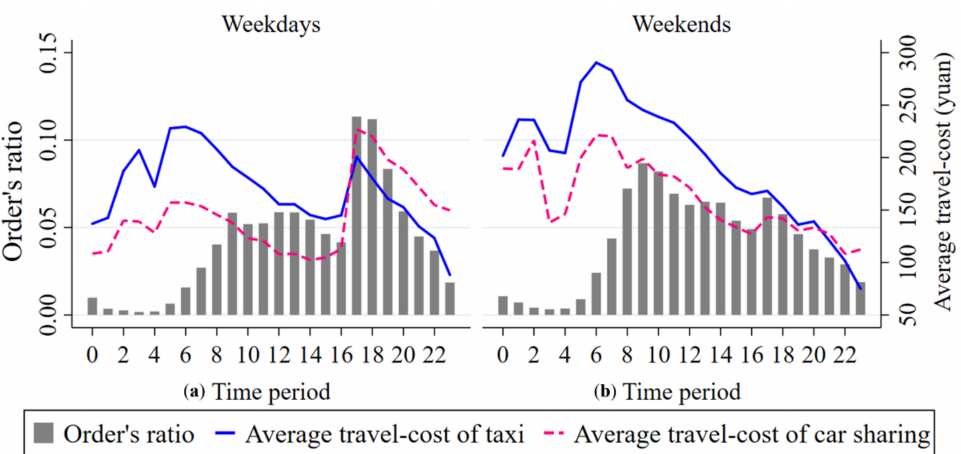
Figure 14. Comparison of travel-cost between taxis and car sharing in di ff erent time periods on weekdays ( a ) and on weekends ( b